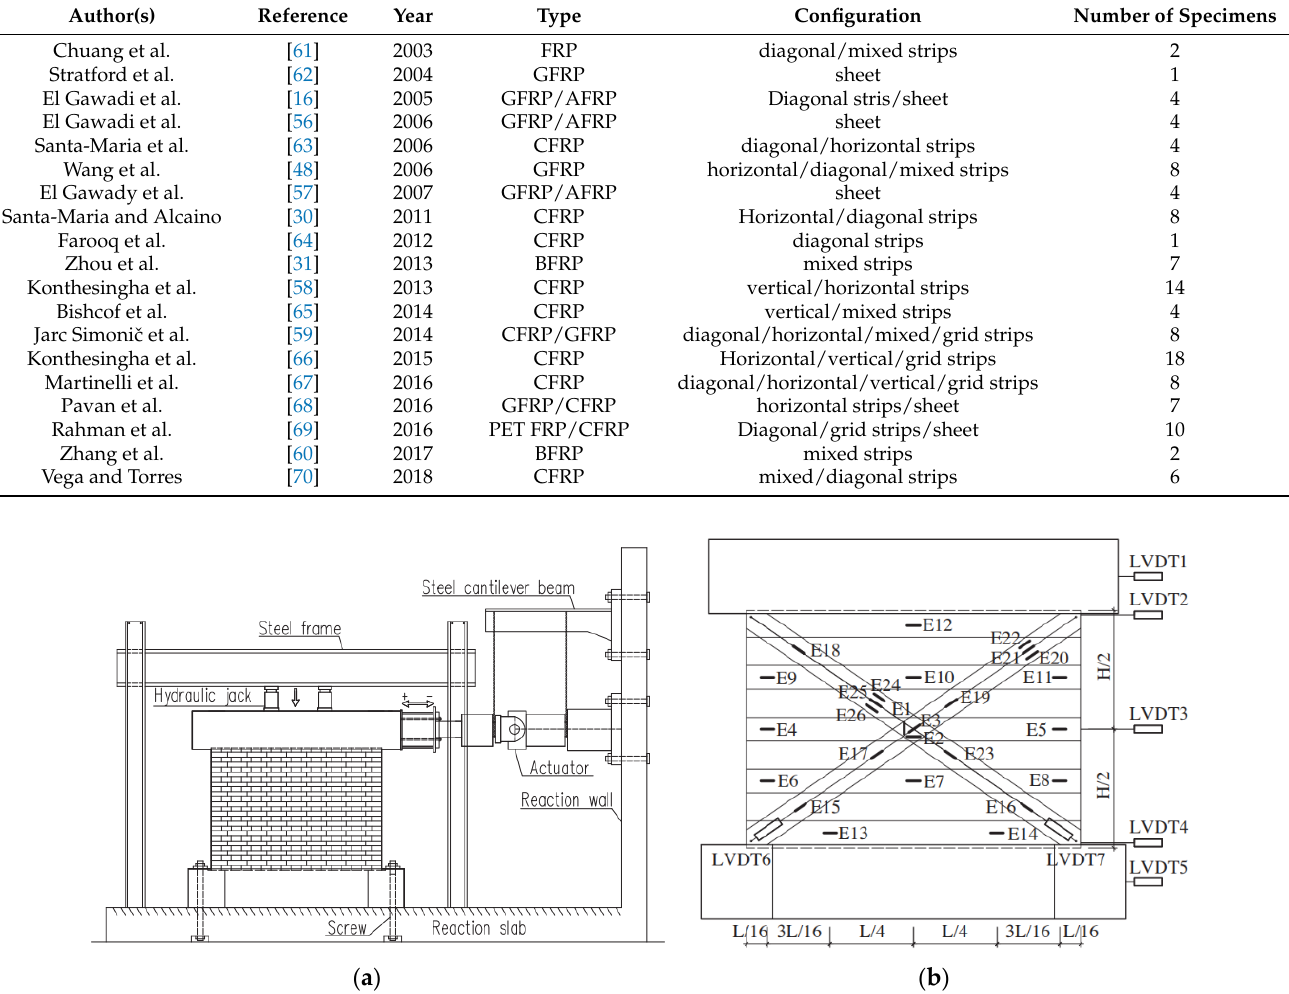
Table 1. General information on the experimental FRP-reinforced masonry samples included in the database.